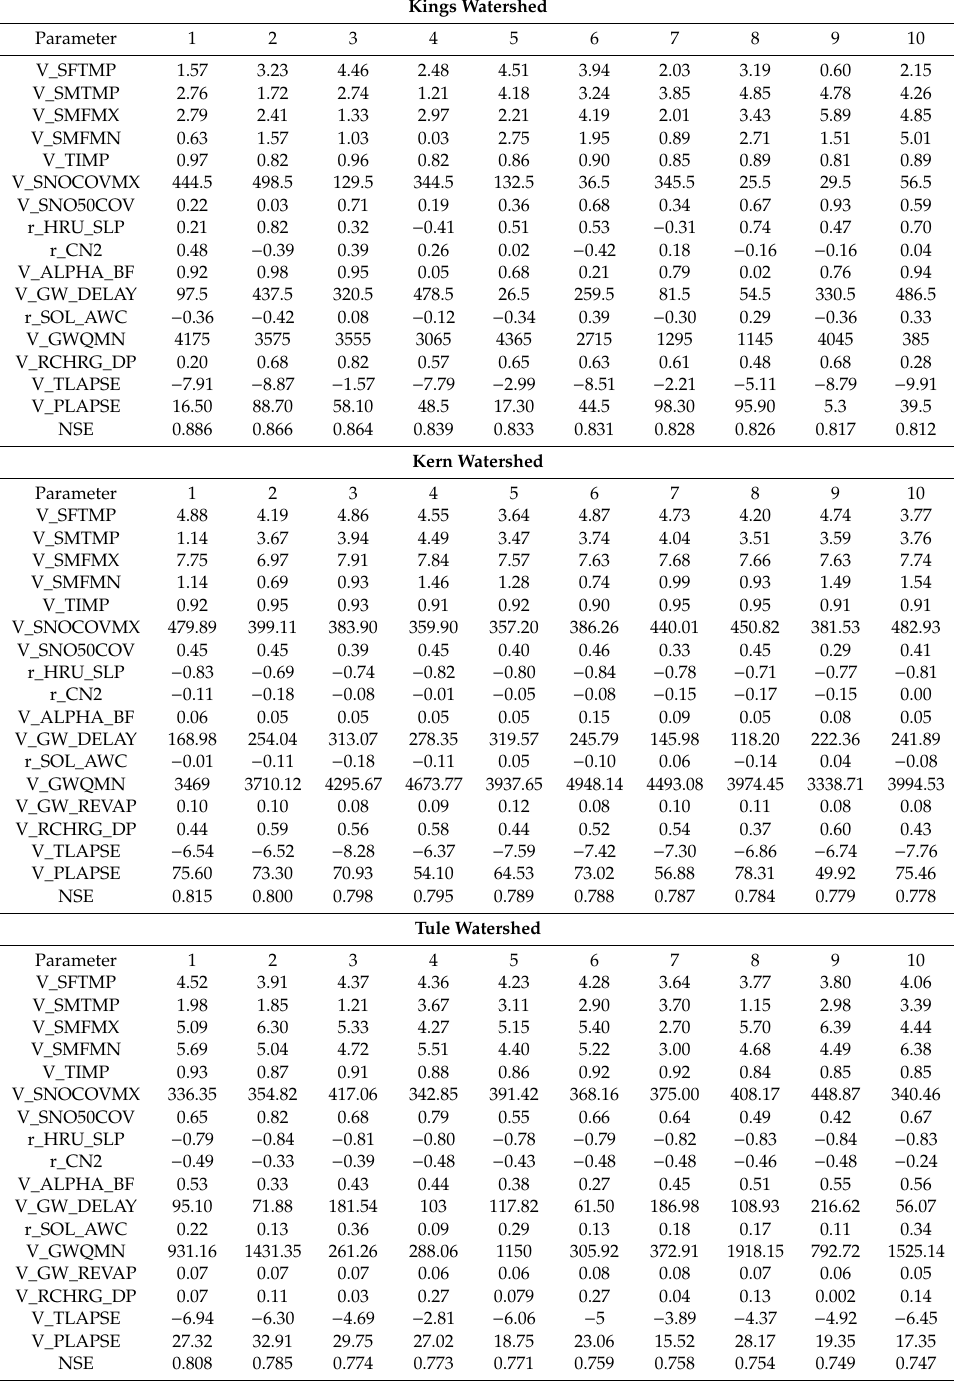
Table A1. The 1st to 10th best parameter sets (rank1–rank10 correspond to the 10 sets of highest NSEs) from the last 500 simulations of the stage 1 calibrations in S3 for each